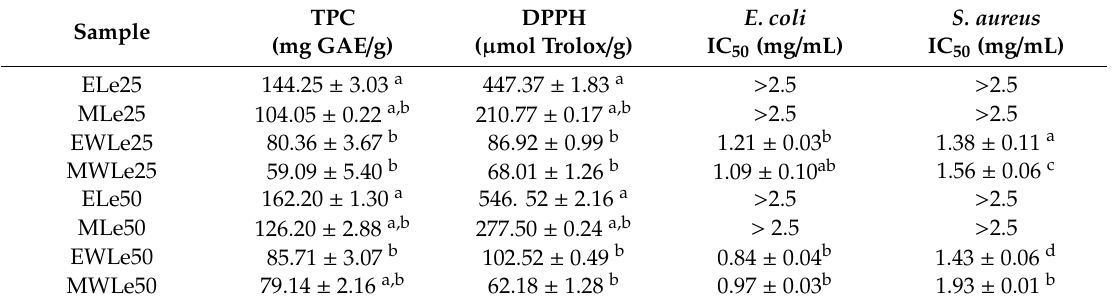
Table 3. Total phenolic compounds (TPC), antioxidant activity (DPPH free radicals scavenging assay expressed as TEAC value) and antimicrobial activity (IC 50 mg / mL) of licorice UAE extracts.